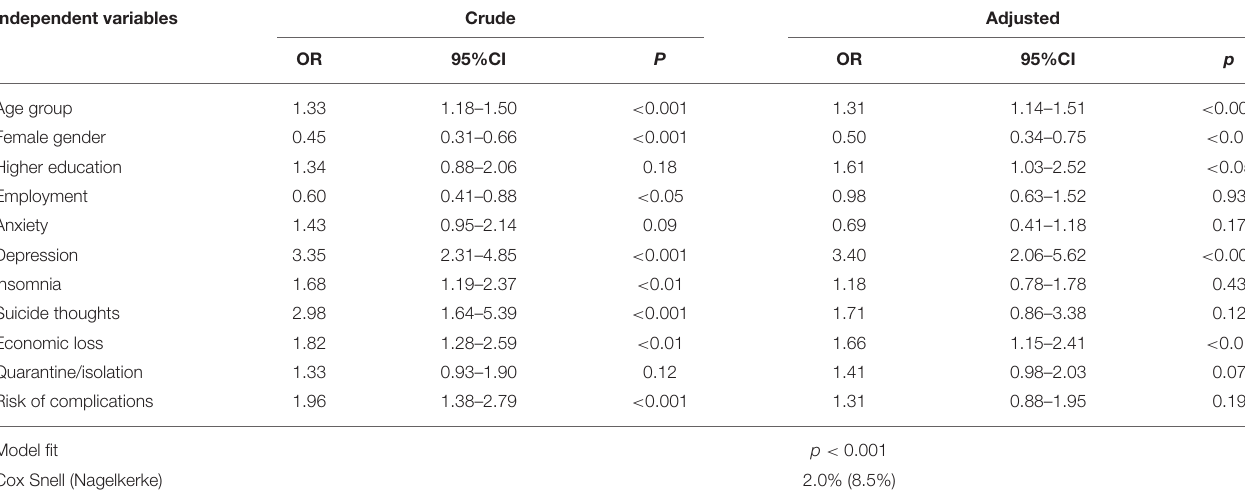
TABLE 2 | Associations with daily use of alcohol.